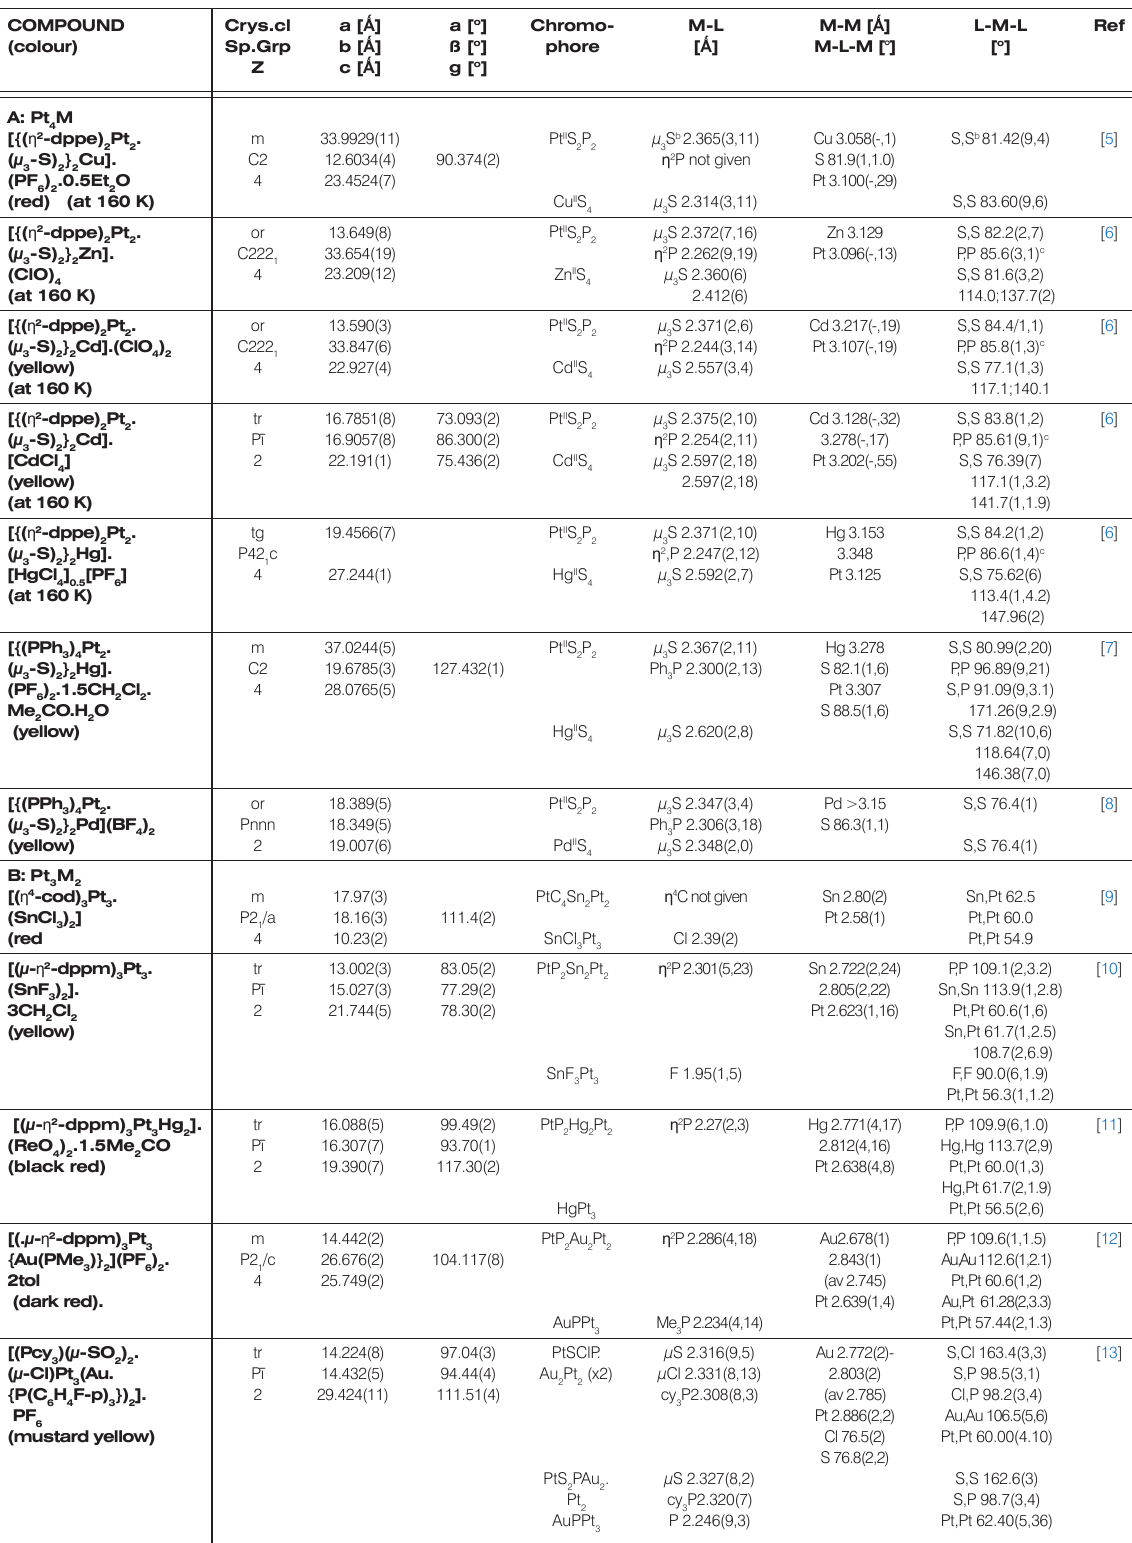
M, Pt M and Pt M ) a . 4 3 2 2 3